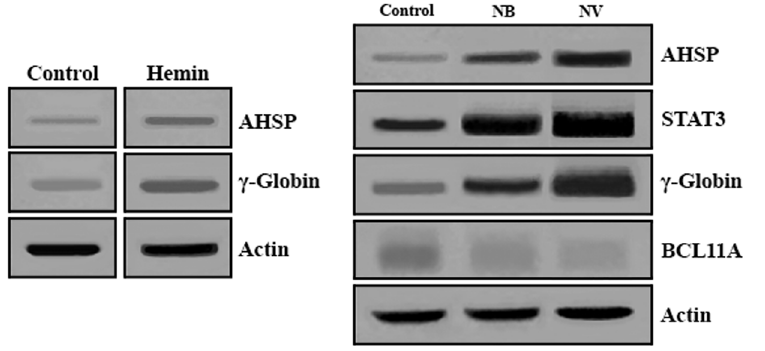
Fig 3. Protein expression analysis by western blotting. K562 cells were cultured with or without sodium phenylbutyrate 1 mM (NB), sodium valproate 1 mM (NV) and hemin 50 μM. After 6 days, the cells were examined for STAT3, AHSP, γ -globin and BCL11A protein expression by Western blot analysis. To normalize protein loading, the blot was hybridized with β -actin